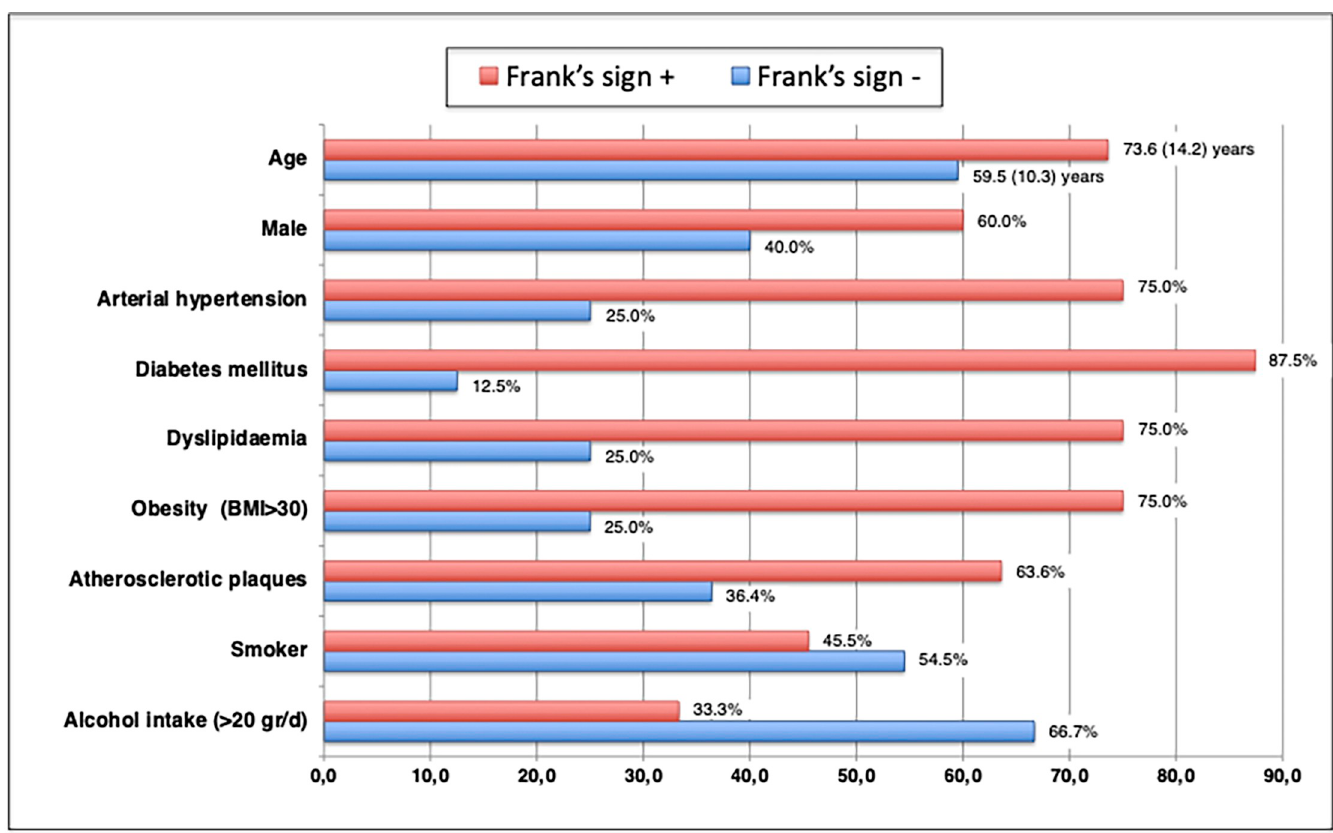
Fig 2. Frank’s sign by clinical variables in ESUS. Age and prevalence of the main atherosclerotic risk factors in ESUS patients by the presence or not of ELC. Except in the case of age, the X axis represents the percentage of patients with the risk factor recorded on the Y axis. Age is expressed as mean